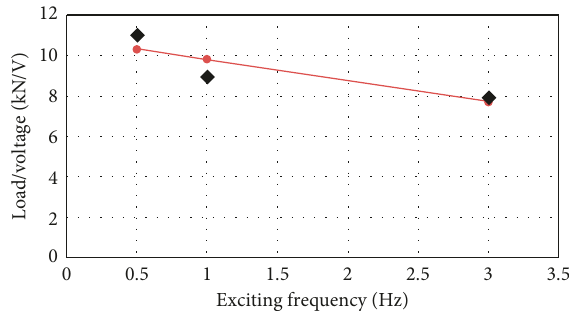
Figure 6: Least-squares fitting between the slope of the output voltage-load lines and the loading frequency.